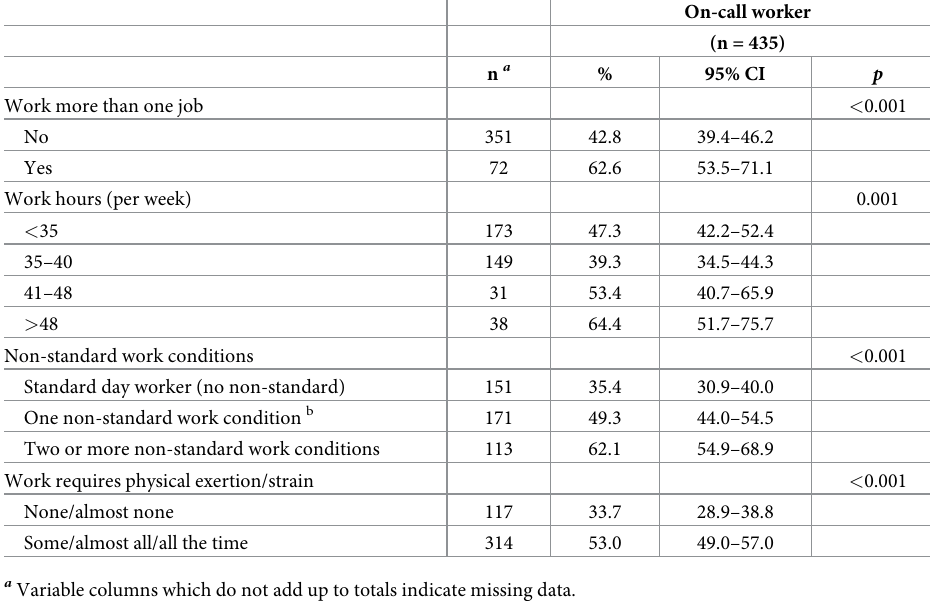
Table 2. Prevalence of self-reported on-call work by occupational